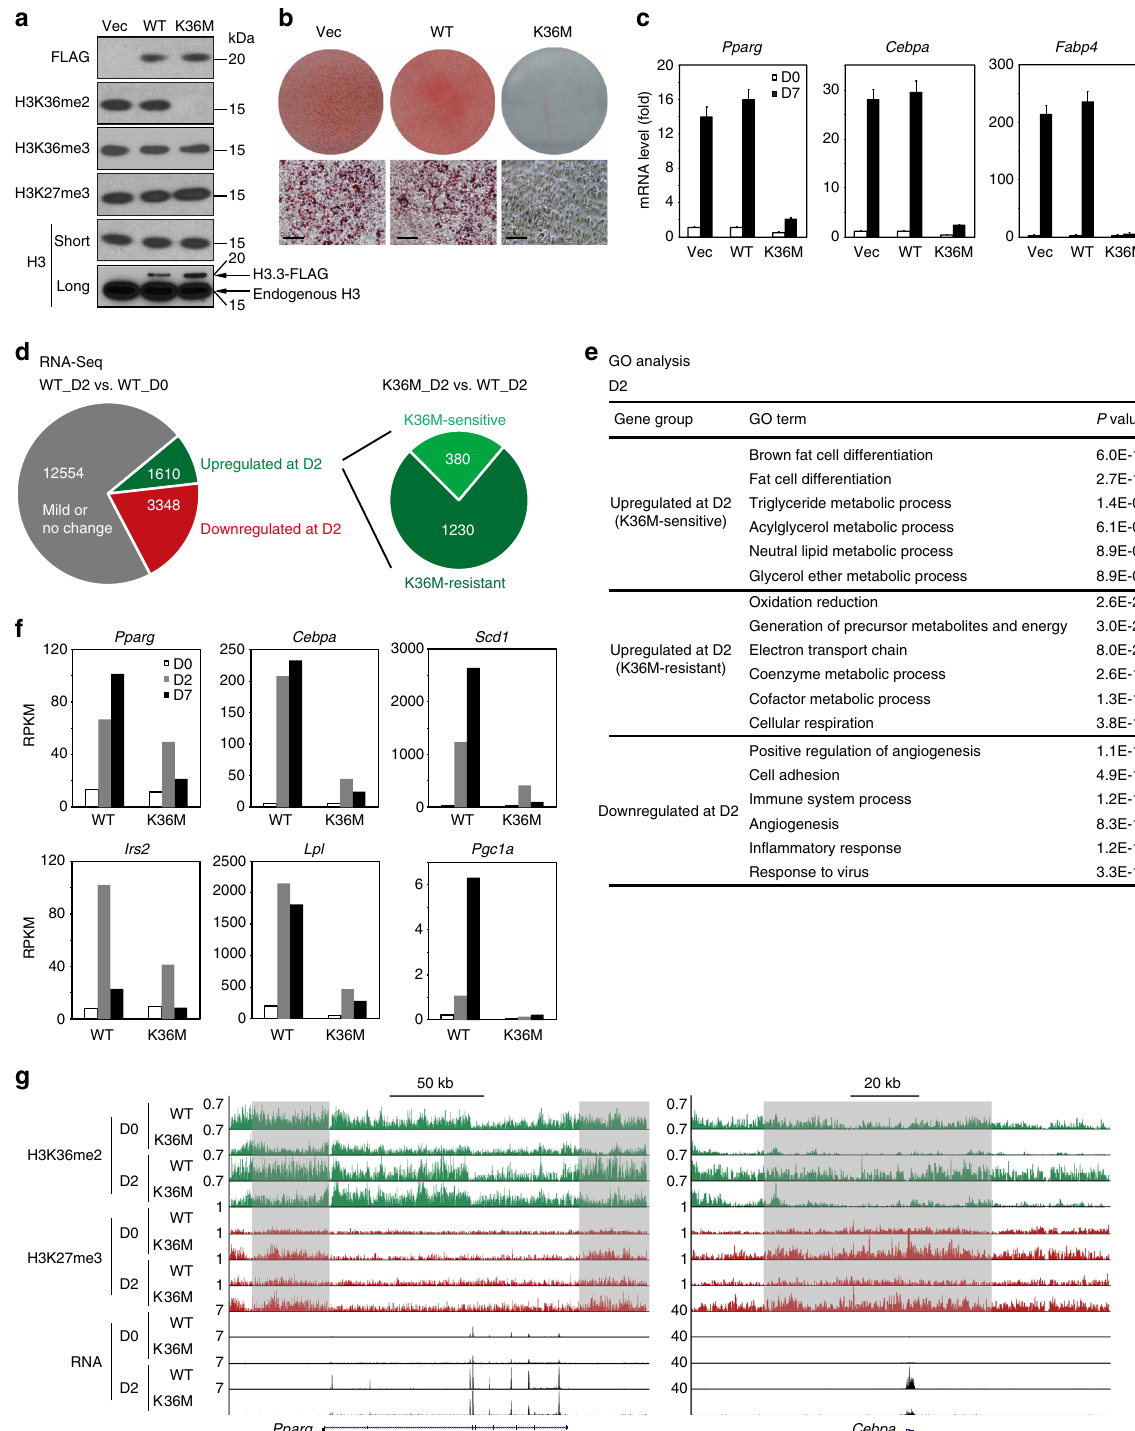
to prevent the induction of C/EBP α and other adipogenic genes. H3.3K36M inhibits PPAR γ target gene expression . Next, we investigated whether ectopic expression of adipogenic transcrip- tion factors C/EBP α or PPAR γ can rescue the adipogenesis defects in H3.3K36M-expressing preadipocytes (Supplementary